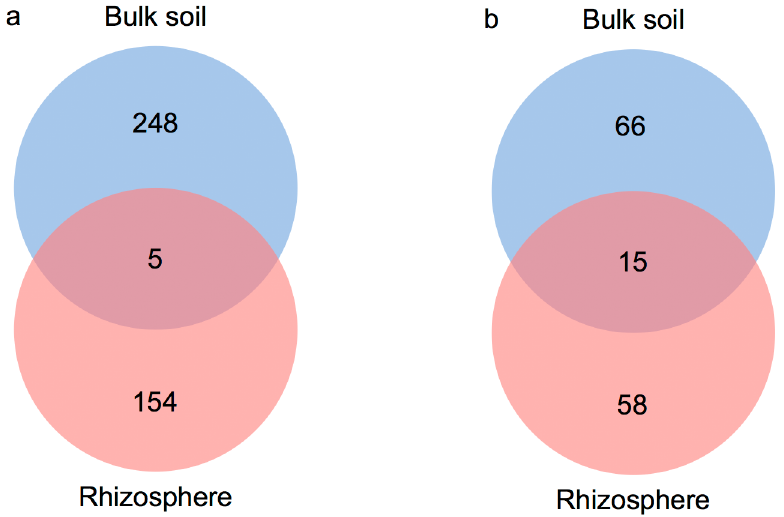
Fig 4. Venn diagram showing the number of shared phylotypes of (a) bacteria and (b) fungi between the rhizosphere and bulk soil communities.